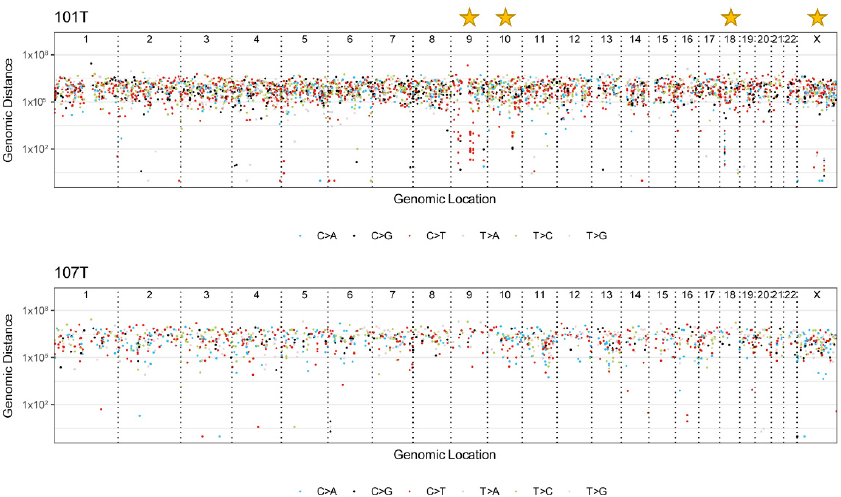
fined by COSMIC Mutational Signatures. Tumor cases are distributed along the Y axis, with each unique mutational signature detailed along the X axis. The relative contribution of each SBS signature per case is annotated with a color scheme.